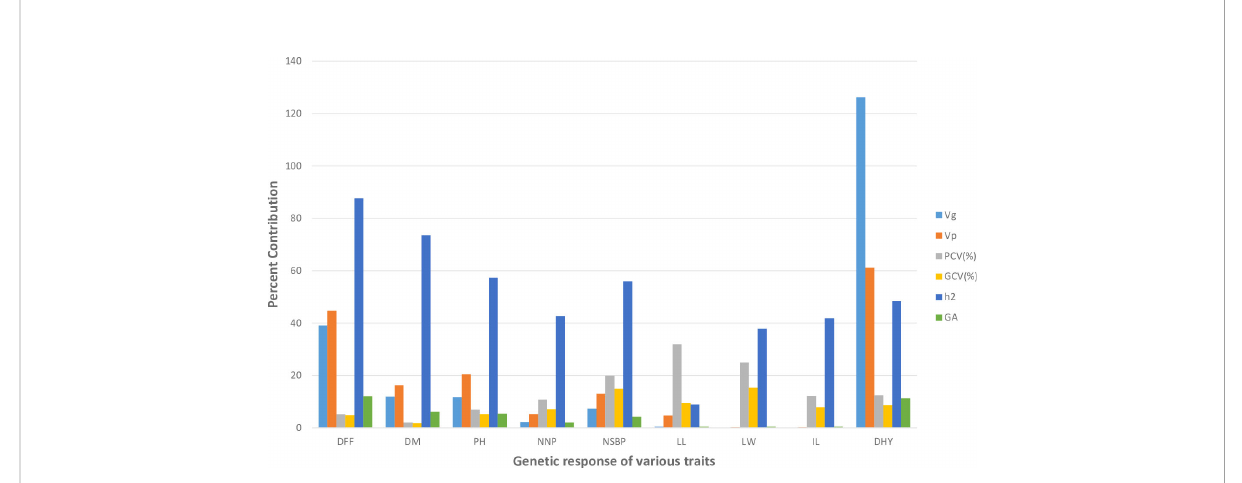
FIGURE 2 Graphical representation of genetic variability parameters estimated for nine quantitative traits in the present